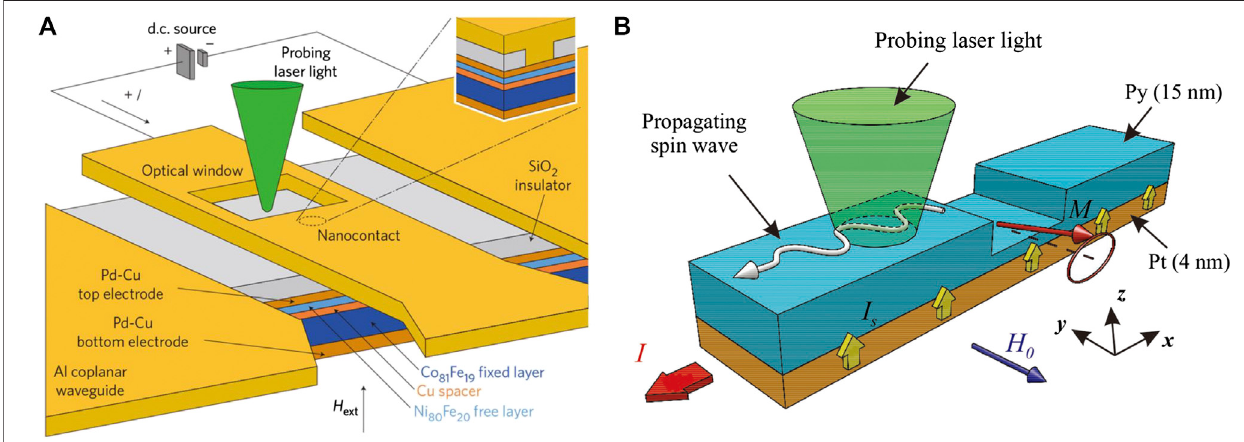
FIGURE6|(A) Cross-sectionofspin-waveexcitationdevicebasedonSTT.AnaluminumcoplanarwaveguideisdepositedontheSTTmultilayerstructure,andan optical window is etched on the waveguide conductor center near the nanocontact point. Polarized current is injected into the STT structure through the nanocontact point to realize spin-wave excitation (Madami et al., 2011). Reprinted with permission from Madami, M., Bonetti, S., Consolo, G., Tacchi, S., Carlotti, G., Gubbiotti, G., et al. (2011). Direct observation of a propagating spin wave induced by spin-transfer torque. Nature nanotechnology 6 (10), 635. Copyright 2011 Springer. (B) Schematic diagram of spin-wave excitation and ampli fi cation device based on SOT. A current in the direction of -x is applied to the permalloy (Py) layer, and a spin polarized current in the direction of z is generated. The Py layer is the spin-wave waveguide with a rectangular notch with a width of 200 nm and a depth of 10 nm in